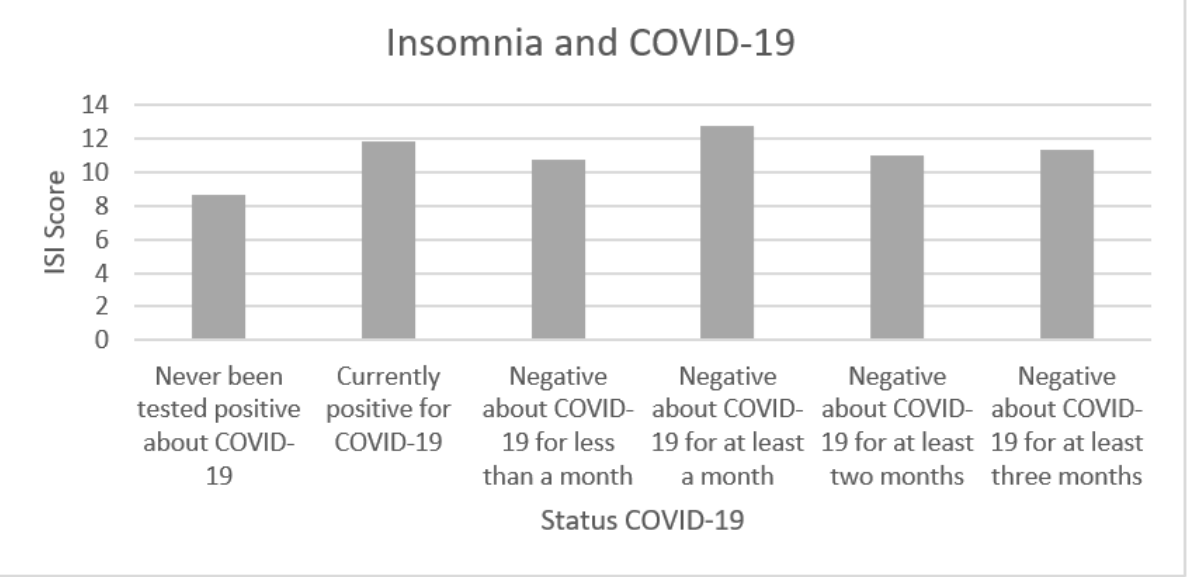
Figure 2. The mean values of the scores indicated by the subjects regarding their Figure 3. The mean values of the scores indicated by the subjects regarding their insomnia (ISI score) are reported, stratified insomnia (ISI score) are reported, stratified by COVID-19 status. by COVID-19 Table 3. Mean values (M) and standard deviation (SD) of the ISI scores stratified according to the different COVID-19 conditions.